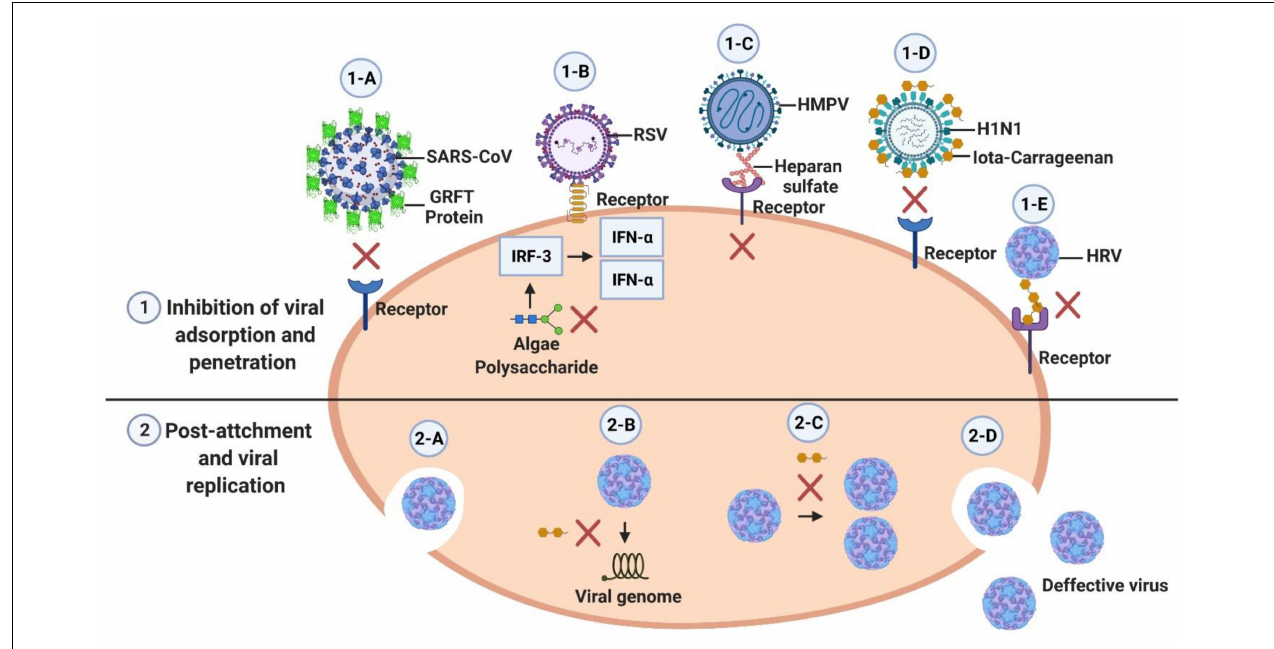
FIGURE 1 | The mechanisms of the action of natural compounds can be divided into two phases: before and after viral entry. 1-A: GRFT Protein from the Griffithsia sp. macroalgae binds to specific oligosaccharides in the virus envelope glycoproteins and block viral entry (O’Keefe et al., 2010). 1-B: Polysaccharides from Laminaria japonica enhance the expression level of IRF3 and the secretion of IFN alpha that results an antiviral activity against RSV. 1-C: The binding of HMPV to heparan sulfate involves charge-charge interactions; this blocks the binding of HMPV to the receptor and consequently inhibits the infection of cells (Klimyte et al., 2016) 0.1-D: Iota-carrageenan from red algae has a long chain of negatively charged molecules that attract and capture positively charged viruses and prevent them from infecting cells (Leibbrandt et al., 2010; Eccles, 2020). 1-E: Iota-carrageenan binds to the surface of rhinovirus and inhibits virus binding to cell receptors (Grassauer et al., 2008). 2-A: Viral entry. 2-B Iota-carrageenan also has an inhibitory effect after the virus enters the cell, blocking the conformational changes of rhinovirus necessary for infection (2-B: uncoating and 2-C: replication) Iota-carrageenan acts occludes virion surfaces involved in binding to cellular proteins required for the infectious process; this prevents replication and results in the viral particles produced being defective (Buck et al., 2006; Grassauer et al., 2008). 2-D: Exit of defective viral particles.